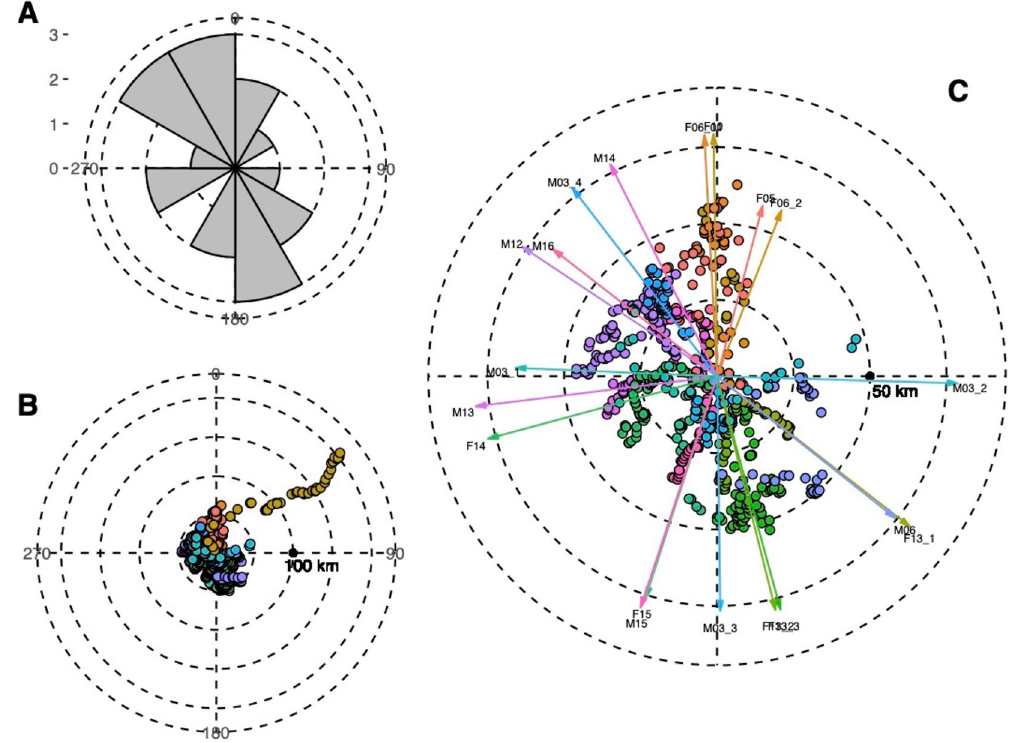
Figure 4. ( A ) Frequency distribution of mean angles (μ) of all long-range exploratory movements recorded from the reintroduction area. ( B ) Direction (in°) and distance from the centroid of the reintroduction area (in km) of all the locations of the exploratory movements. Each colour represents a different event. ( C ) Arrows represent the mean movement angle of each exploratory event (μ) and are proportional to the vector length (r). The longest exploratory event (F06) is